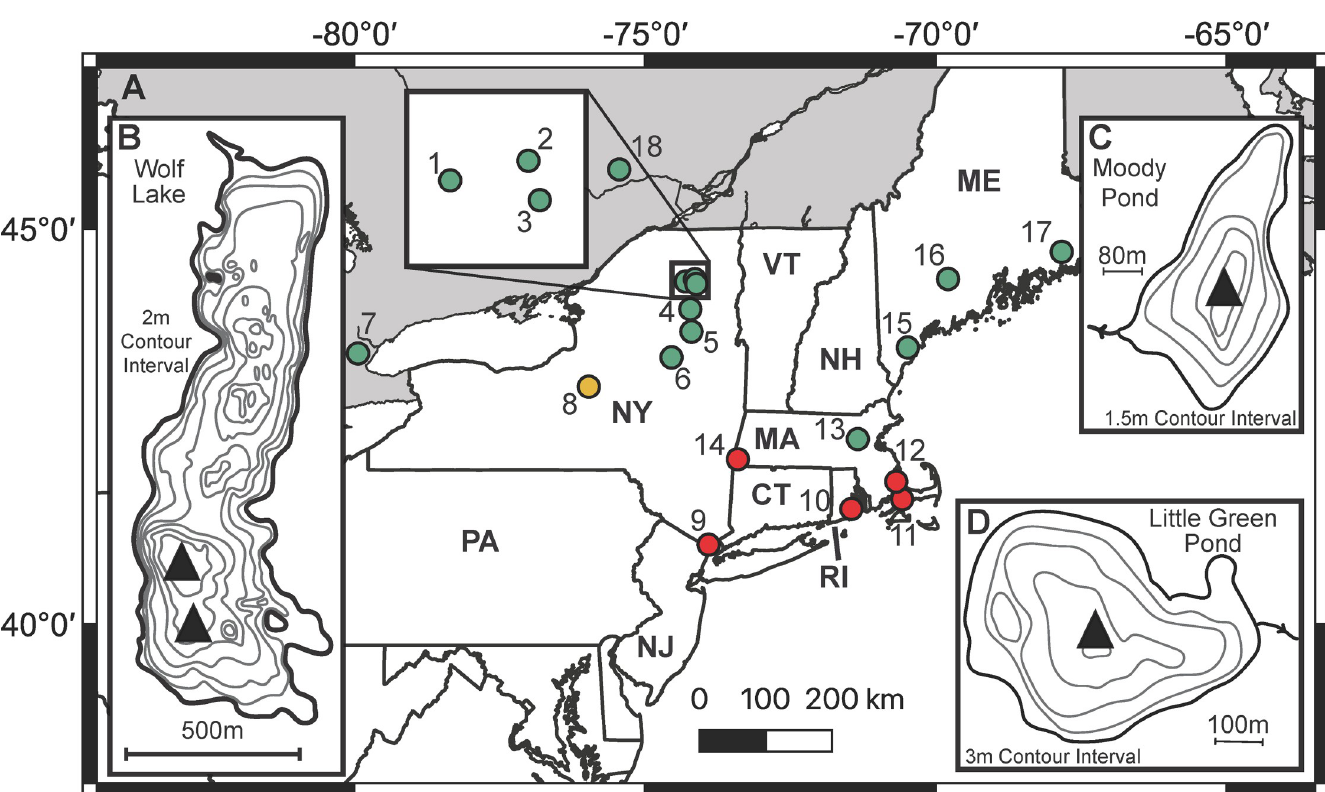
Fig 1. Site maps. Panel A. Northeastern region with locations of paleoclimate study sites referred to in the text. Green sites registered one or both of the dry phases of the DWD oscillation, red sites did not, and the yellow site was equivocal. Panels B, C, D. Contour maps of Wolf Lake, Moody Pond, and Little Green Pond respectively, with coring sites indicated by black triangles. Study sites shown on regional map: 1. Little Green Pond, 2. Bloomingdale Bog, 3. Moody Pond, 4. Wolf Lake, 5. Clear Pond [8], 6. Piseco Lake [7], 7. Crawford Lake, marking the eastern margin of the study area used by Buckley et al. [9], 8. Fayetteville Green Lake [12], 9. Piermont Marsh [3], 10. Pettaquamscutt River Estuary [12], 11. Deep Pond [13], 12. New Long Pond [14], 13. Walden Pond [11], 14. Davis Pond [14], 15–17. Saco Heath, Sidney Bog, Great Heath Bog, respectively [10]. 18. Lac Brule´ [37].